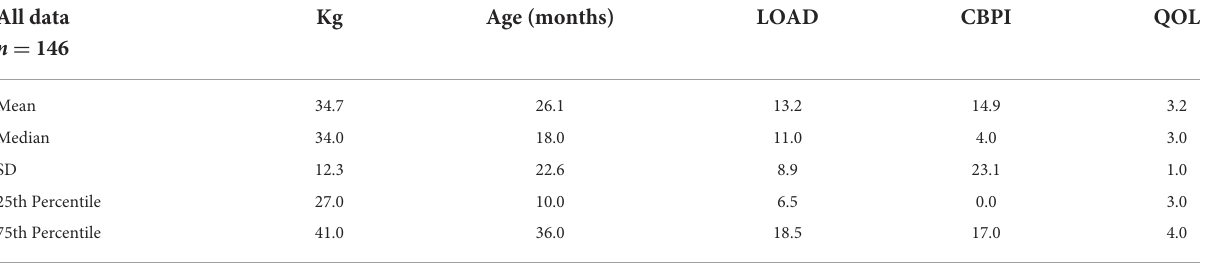
TABLE 1 Summary of all the cases.